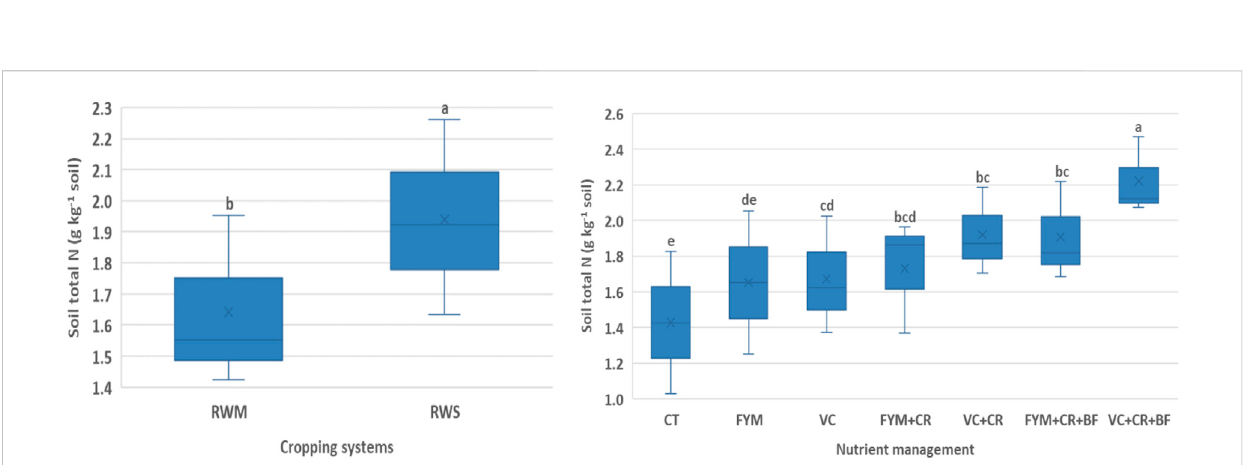
FIGURE 9 Long-term effect of cropping systemsand organic nutrientmanagement on soil totalN.RWM: rice-wheat-mungbean; RWS:rice-wheat-sesbania; CT: control; FYM: farm yard manure; VC: vermicompost; CR: crop residue(s); and BF: biofertilizer(s). Statistical method: analysis of variance for strip-plot design in SAS 9.3 software; n = 42. Values with a different capital letter indicate a signi fi cant difference among the different treatments at p < 0.05 by the LSD test. Bars represent means ±